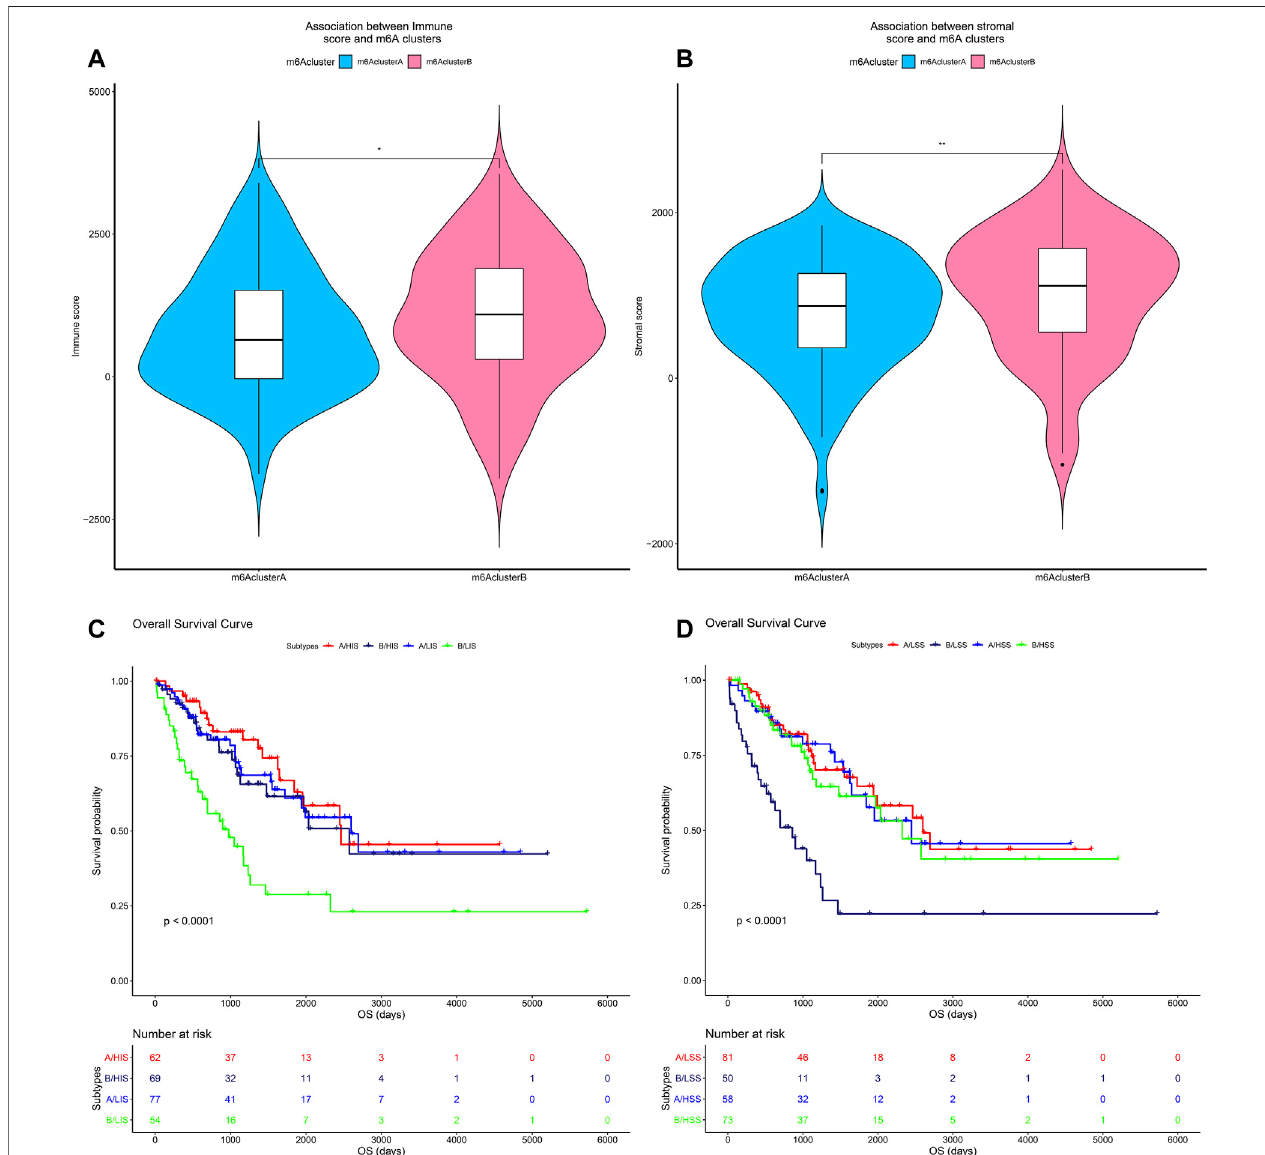
FIGURE 6 | Effects of different m6A modi fi cation patterns on the immune in fi ltration of STS. (A) Comparison of immune score among m6A clusters A and B; (B) Comparison of stromal score among m6A clusters A and B; (C) survival analysis of different immune scores among m6A clusters A and B (A: m6A cluster A, B: m6A clusterB,LSS,lowimmunescore,andHSS,highimmunescore);and (D) survivalanalysisofdifferentstromalscoresamongm6AclustersAandB.(A:m6AclusterA,B: m6A cluster B, LIS: low stromal score, and HIS, high stromal score); p < 0.05* and p < 0.01**.